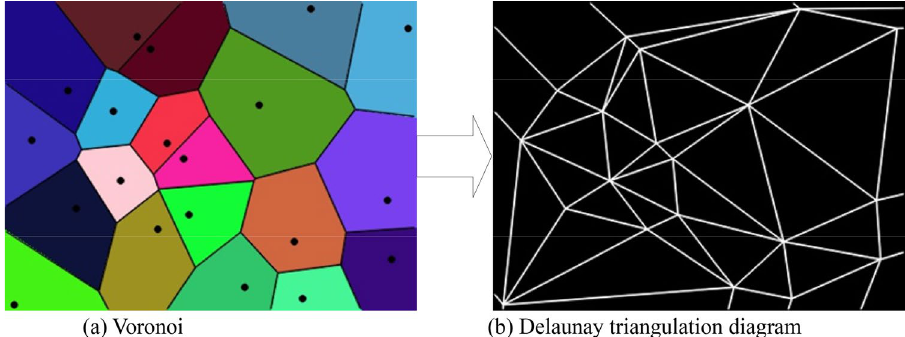
Figure 3. Voronoi and delaunay